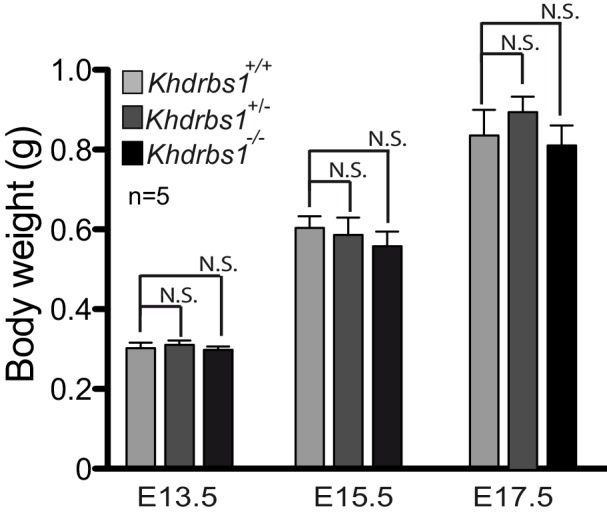
Ablation of Khdrbs1 does not affect overall embryo development.Weight analysis of Khdrbs1+/+, Khdrbs1+/- and Khdrbs1-/- mouse embryos at E13.5, 15.5 and E17.5. At least 5 embryos for each genotype were weighted. Statistical analysis was performed using the ANOVA one-way test and Tuckey post-test.